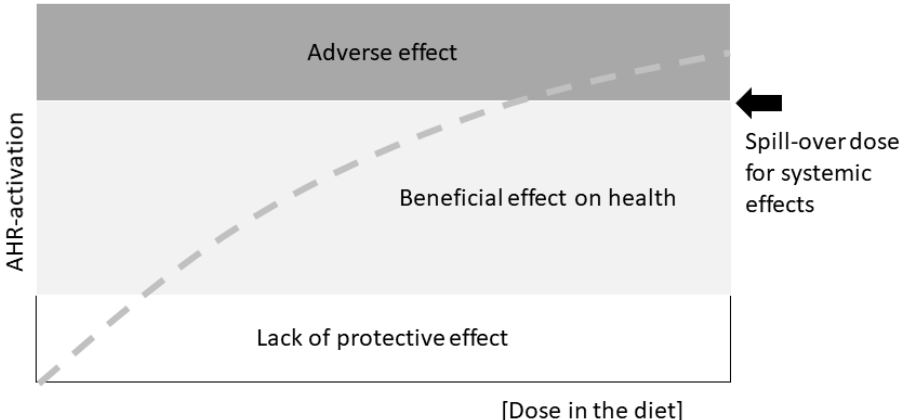
Figure 1. Graphical scheme of the possible health effects of a diet-provided AHR ligand at different doses. The thresholds will have to be determined experimentally. Not included are off-target effects or the possibility of effects of metabolites of the original agonist. Drawn after a slide presented by Gary Perdew at the AHR2018 meeting in Paris.